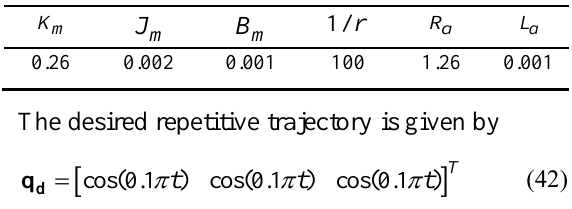
Table 1. Parameters of dc